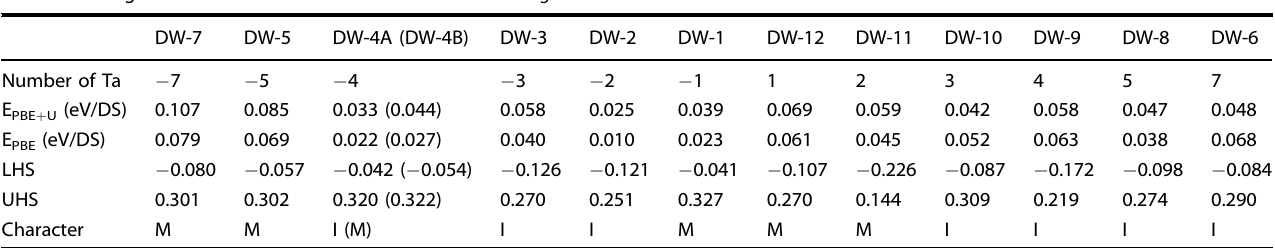
Fig. 1 Domain and domain-wall structures in quenched 1T-TaS 2 . a and b Two independent STM images (sample bias voltage V s = − 1.2 V, tunneling current I t = 10 pA, size L 2 = 80 × 80 nm 2 , scale bar = 10 nm). The line colors denote the type of domain wall: DW-1: yellow, DW-2: white, DW-4: blue, and zigzag domain wall: green. c David-star cluster of the CCDW phase with thirteen Ta atoms indexed. A DW is de fi ned as the center of DS clusters of the neighboring domain sits on Ta atomic sites of 1 – 12, which is indexed as DW-1-DW-12, respectively. d – f Schematic arrangement of David stars for the domain walls. d DW-2, e DW-1, and DW-4, and f zigzag domain wall (DW-1,4). Orange arrows denote the CCDW vector. Solid (dashed) parallelogram in e denotes the domain-wall unit of DW-1 (DW-4). Table 1. Energetics and electronic structure of all twelve straight domain